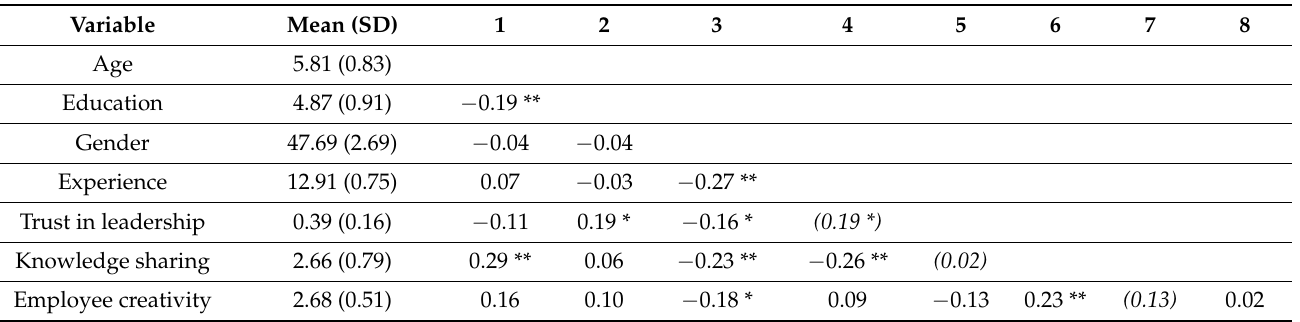
Table 2. Descriptive statistics and